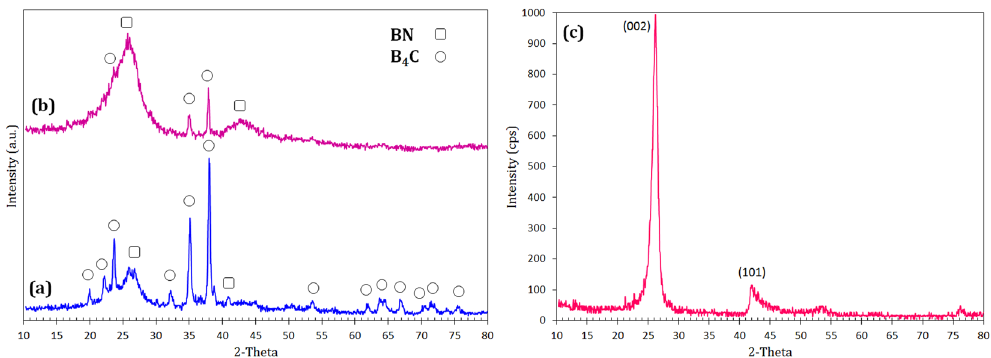
Figure 2. X-ray diffraction patterns of the ( a ) M10, ( b ) M16, and ( c ) M23 samples after combustion and the leaching